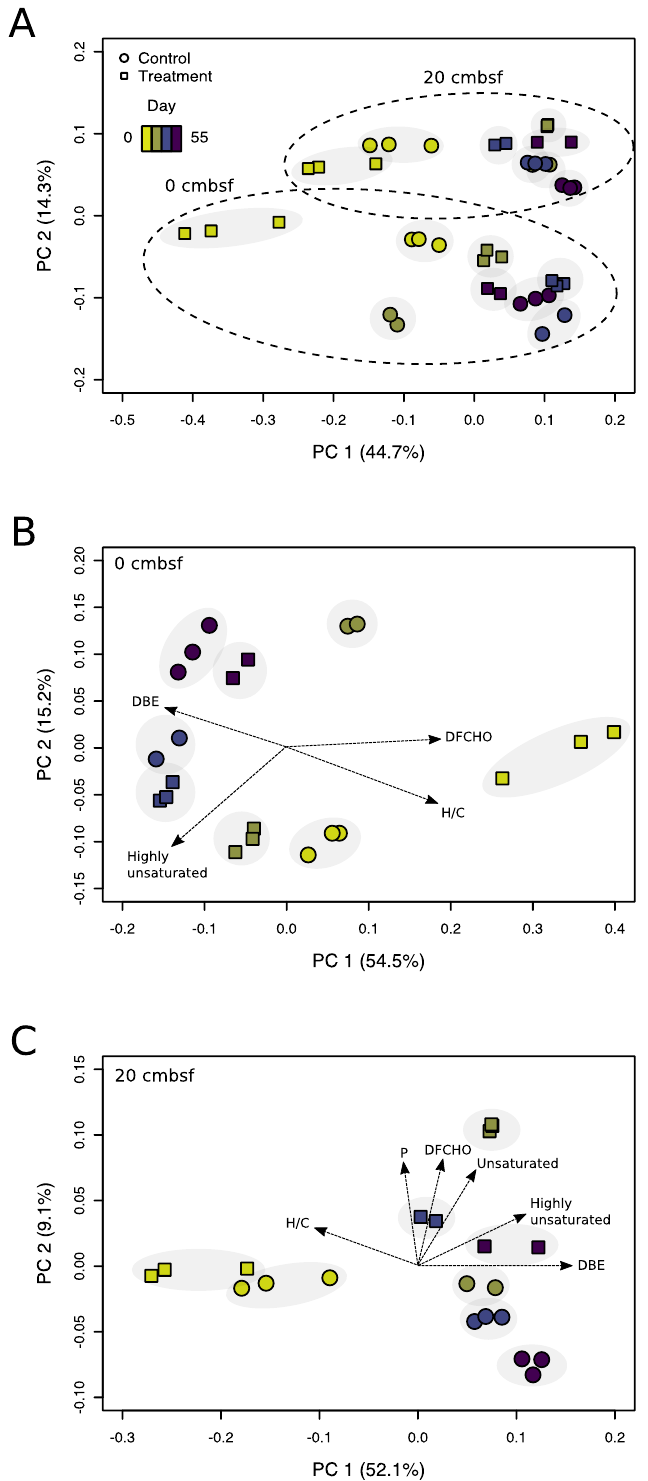
Figure 3. Principal coordinate analysis based on Bray-Curtis dissimilarities of relative peak intensities. Calculated for ( A ) the samples of both depths, ( B ) samples from the 0 cmbsf and ( C ) 20 cmbsf incubations, color-coded by the main sampling time points (day 0, 6, 14, and 55). The explained variance for the data set is given for the first two major axes of variation. Associated analytical replicates are marked by the gray background. Mitomycin C treated samples are displayed by squares and non-treated controls by circles. Molecular DOM parameters (black arrows) are fitted to the